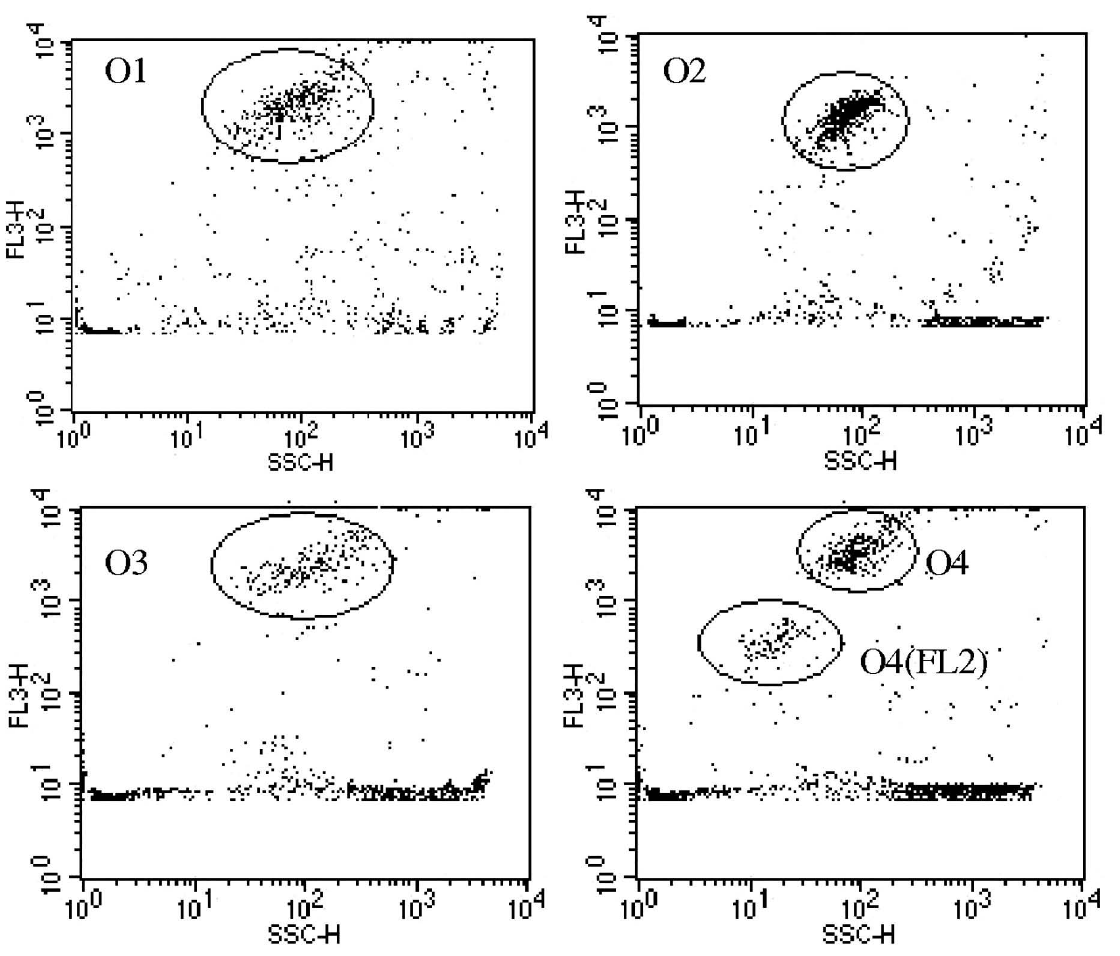
Fig . 4. – Flow cytometry dot plots of cell size vs chlorophyll a signals of oceanic picoeukaryotes (O1, O2, O3, O4) and O4(FL2) cyanobacteria population.